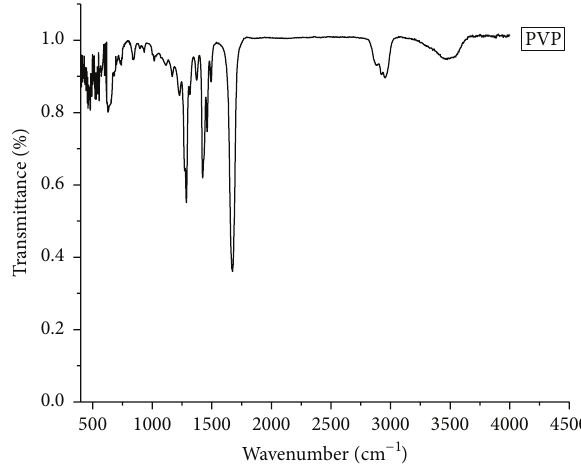
Figure 5: FTIR spectra of